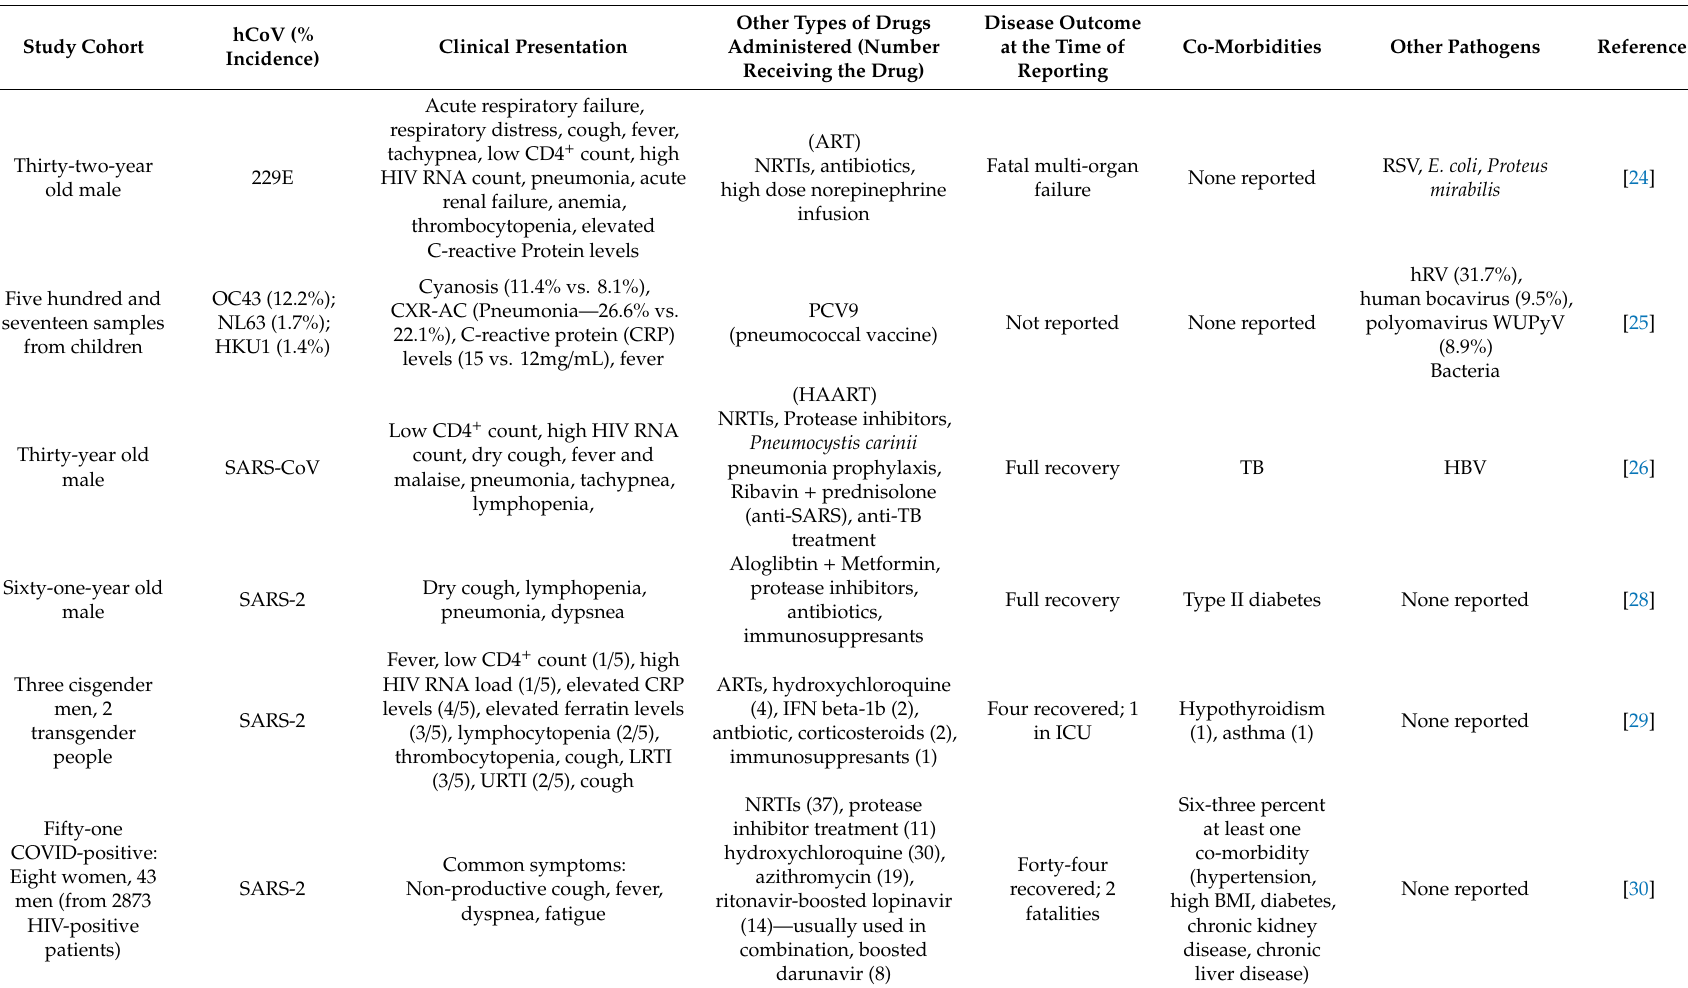
Table 1. Human coronavirus infections in HIV-positive